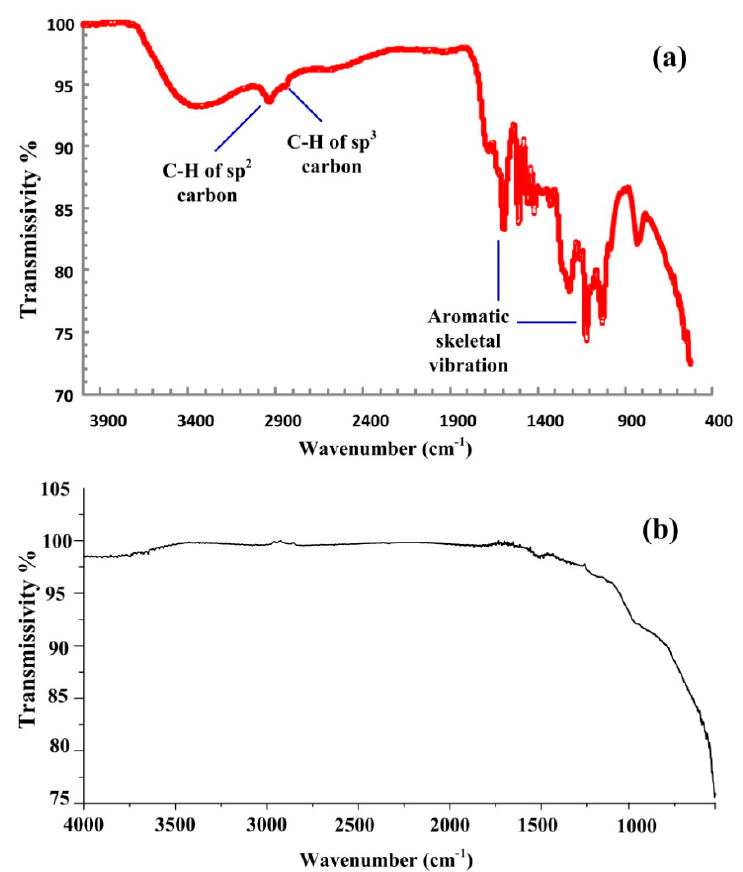
Figure 8. The FTIR spectra of lignin and a GMC sample. ( a ) The FTIR spectrum of lignin (red) isolated and purified from sugarcane bagasse. ( b ) The FTIR spectrum of a GMC sample prepared at 1000 °C. The peaks of C-H bonds and aromatic bonds almost disappear in the FTIR spectrum of the GMC sample, indicating the full carbonization of the precursor lignin during the thermal pyrolyzation reaction.